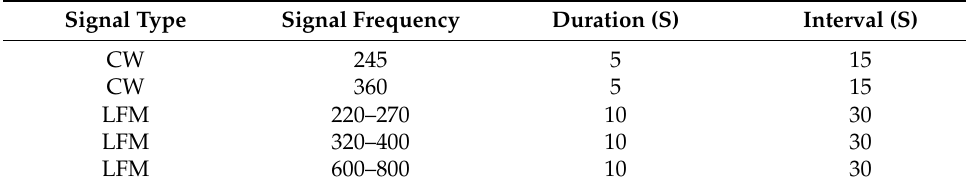
Table 4. Periodic signal.